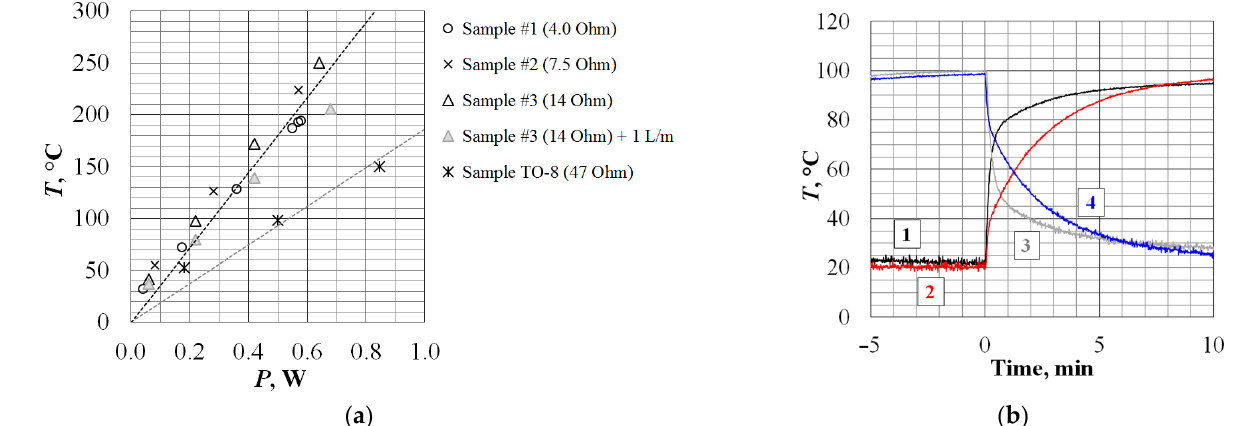
Figure 8. Comparative tests of the energy consumption and thermal inertia of the new (SMD) and old (TO-8) designs of gas sensors. ( a ) Plot with the power consumption of gas sensors required to maintain the operating temperature, including when blowing the sensor with an air flow of 1 l/min. ( b ) Plot of the time required to heat MIS sensors to 100 °C at a constant heater supply voltage (without thermal control) (1—SMD and 2—TO-8) as well as the duration of cooling to room temperature in the absence of voltage on the heater (3—SMD and 4—TO-8).